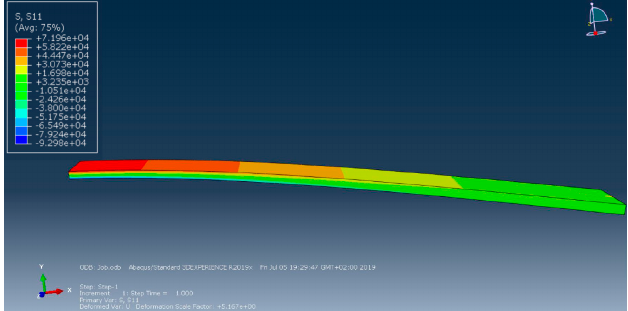
Figure 13. Calculated σ x in one bending test obtained through FEA.